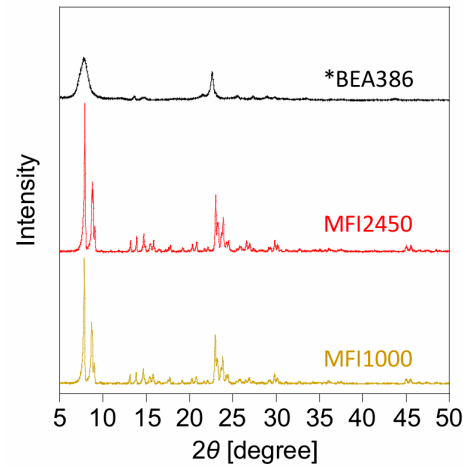
Figure 1. XRD patterns of the synthesized zeolite